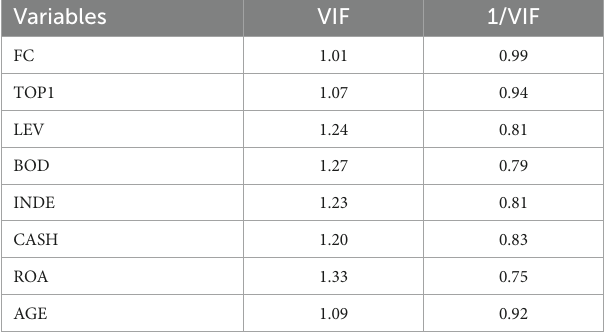
TABLE 3 Multiple collinearity test.